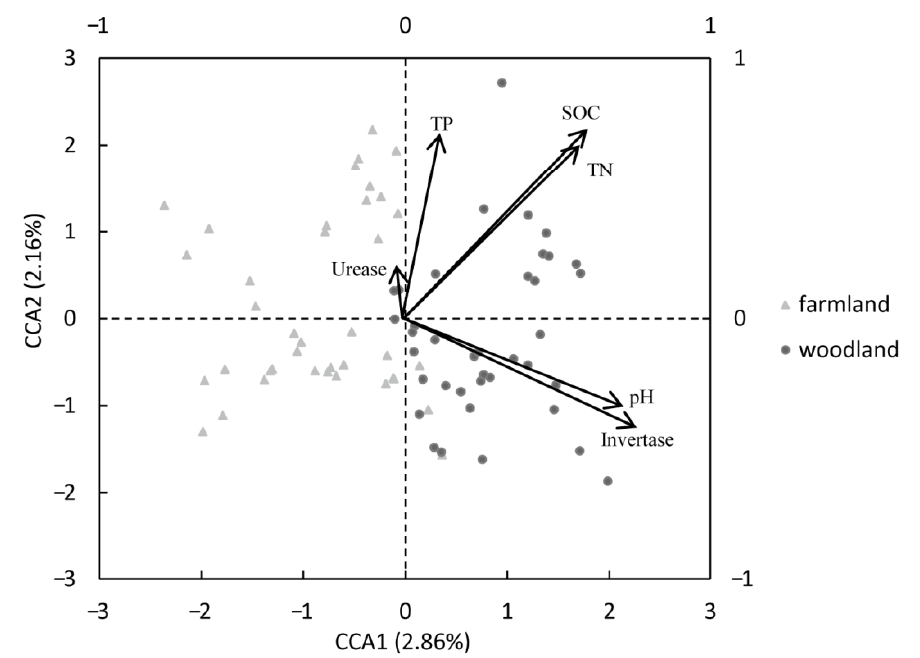
Figure 6. Canonical correspondence analysis (CCA) of the arbuscular mycorrhizal fungal community composition and edaphic factors of farmland and woodland. Edaphic factors include pH, soil organic carbon (SOC), total N (TN), total p (TP), urease activity and invertase activity.